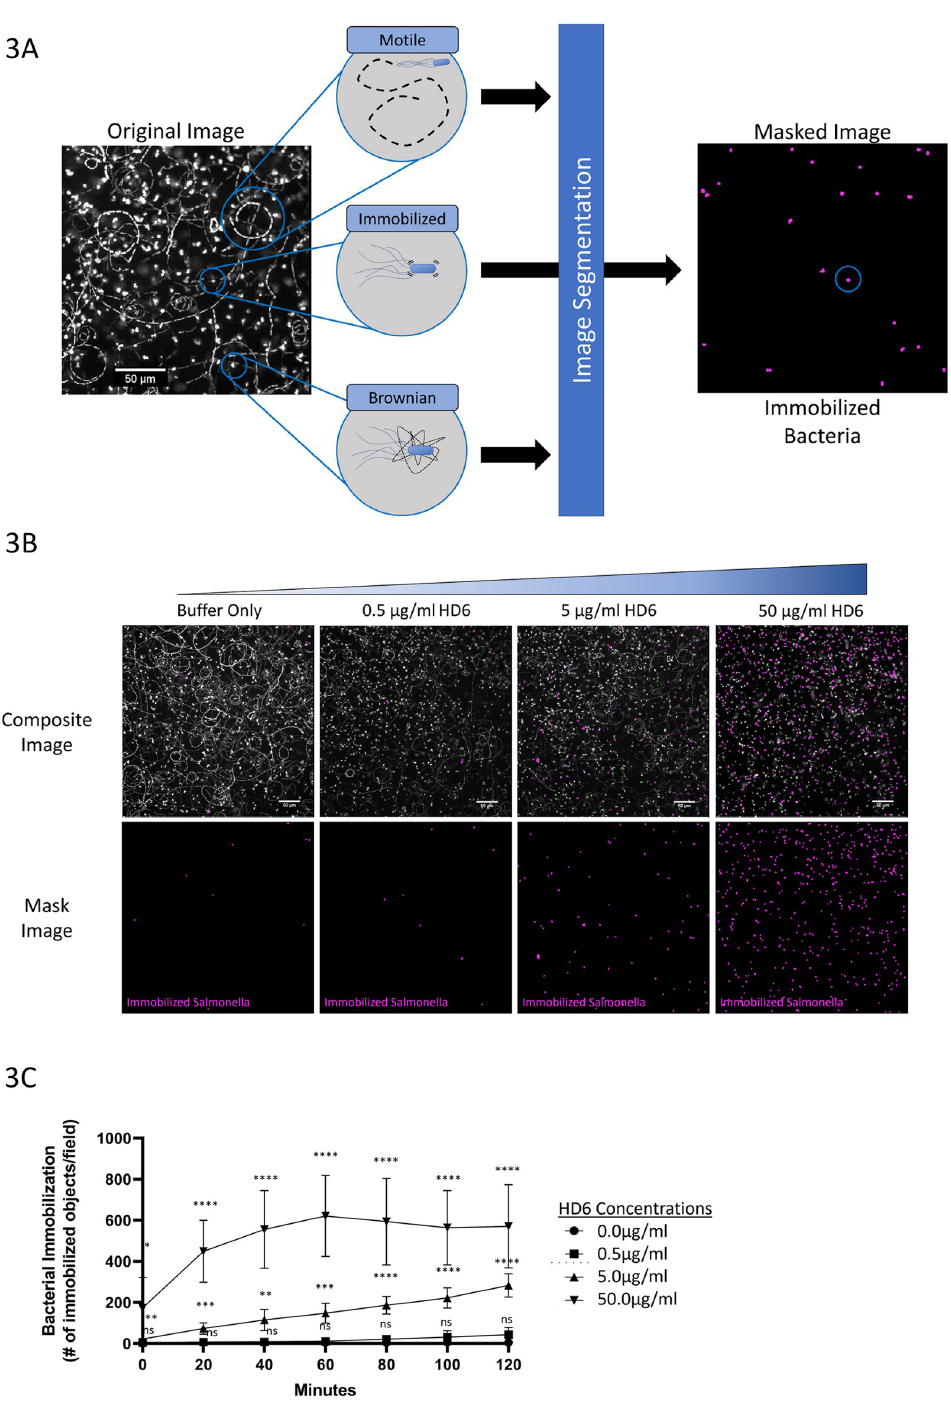
Fig 3. Live-fluorescence microscopy analysis of HD6-mediated S . Typhimurium immobilization. ( A ) Diagram depicting the masking strategy used to identify and quantify immobilized GFP-expressing S . Typhimurium. Left, An original superimposed image (as in Fig 2B) displaying examples of the three patterns of movement: motile, immobilized, Brownian motion. Inset circles, schematic depictions of the three patterns of movement. Right, The image mask identifies and then only displays immobilized bacteria, based on invariant spatial location in the 20 sequential images at each experimental timepoint. The resulting masked image displays the immobilized S . Typhimurium (red) with the image of a single bacterium highlighted (blue circle). Scale bar, 50 μ m. ( B ) Representative unmasked composite data (TOP) and masked image data (BOTTOM), which depict immobilized S . Typhimurium observed in the presence of